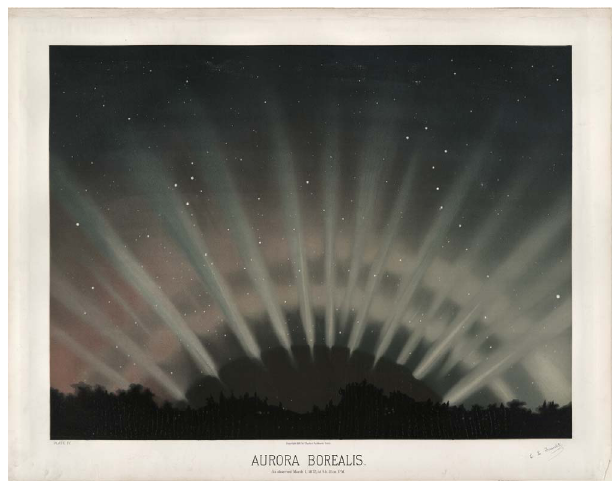
Fig. 6. An illustration entitled “ Aurora Borealis as observed on March 1, 1872 at 9:25 p.m. ” by Etienne Leopold Trouvelot (The New York Public Library Digital Collections,